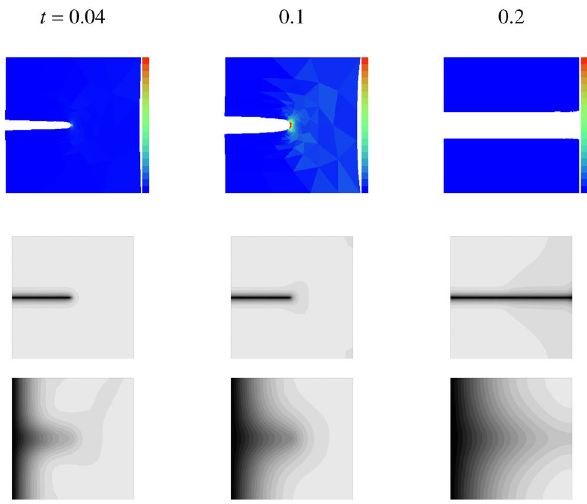
Fig. 22 Snapshots of numerical results with the HE effect ((6.1) with = 0.01 ). Crack growth at a given boundary dis- γ = 0.5 and γ ∗ 1 ∗ 0 placement g = ± t ( 0,1 ) on Γ D when D 0 = 1, D 1 = 100 (deformation (upper), spatial profile of z (middle), and w (bottom)) . In the upper figures, blue color indicates low values, red color high values of the 2 e [ u ] intensity of | |